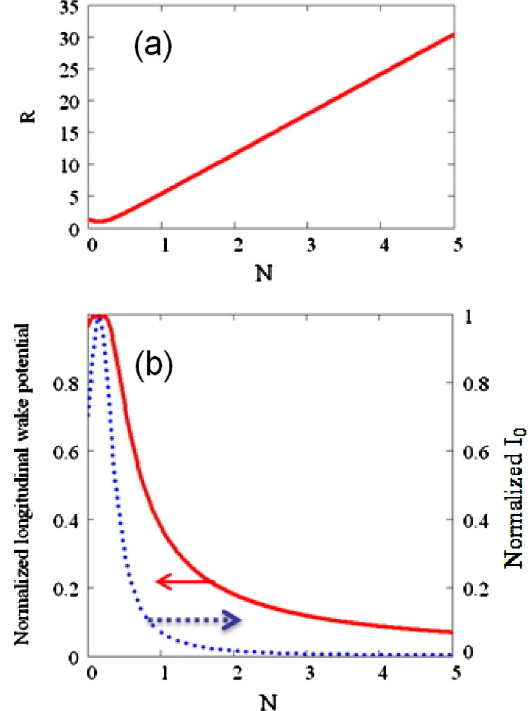
FIG. 8. (a) Plot of Eq. (16): transformer ratio increases as N does; (b) plots of Eqs. (14) and (15): dependences of wake potential (red solid) and the normalization factor I 0 (blue dot) upon N , with the conditions that both Q total and R=Q are constant.